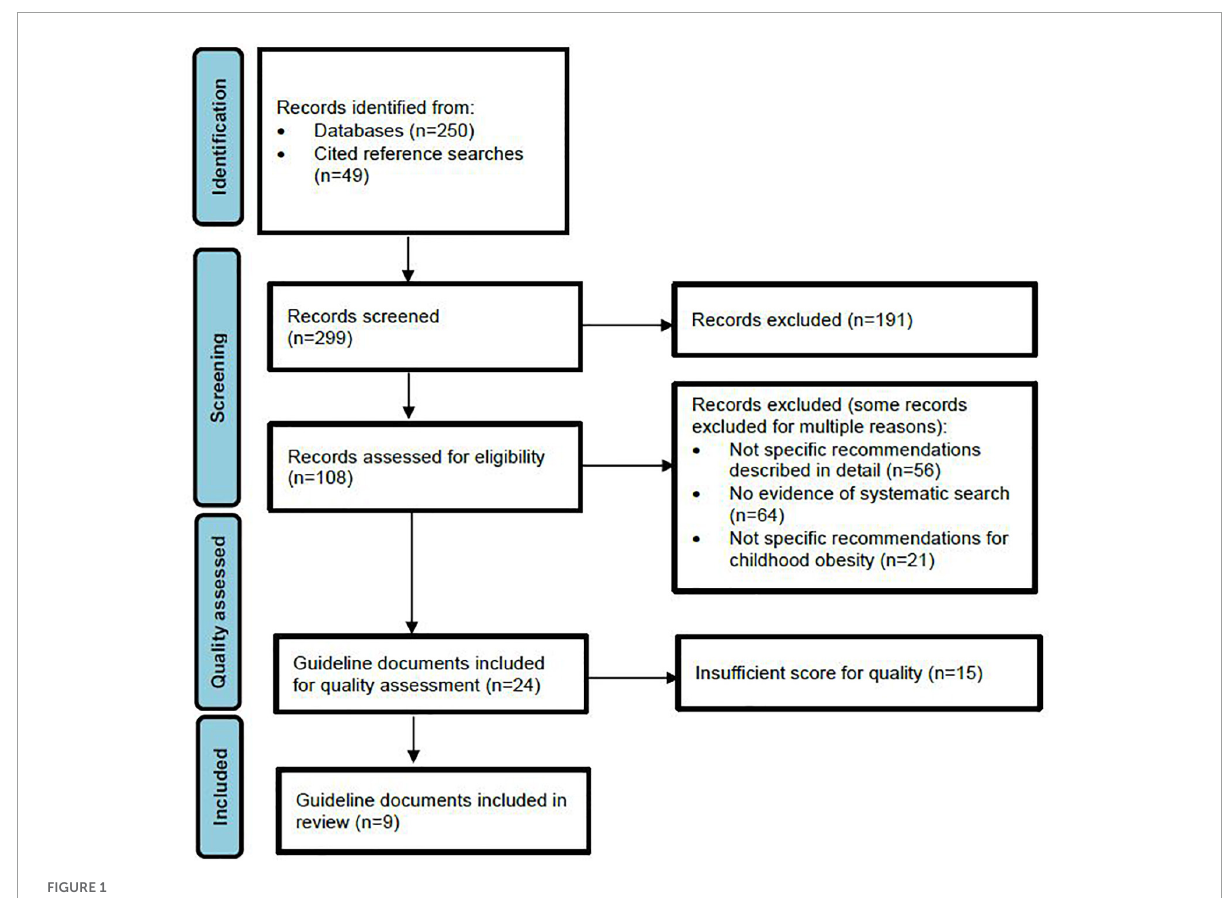
FIGURE1 PRISMA flow